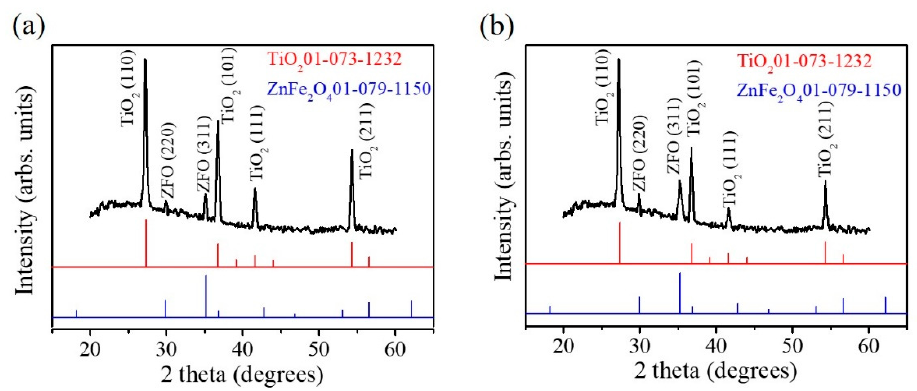
Figure 5. XRD patterns: ( a ) TiO 2 –ZFO-2 nanorods; ( b ) TiO 2 –ZFO-3 nanorods.